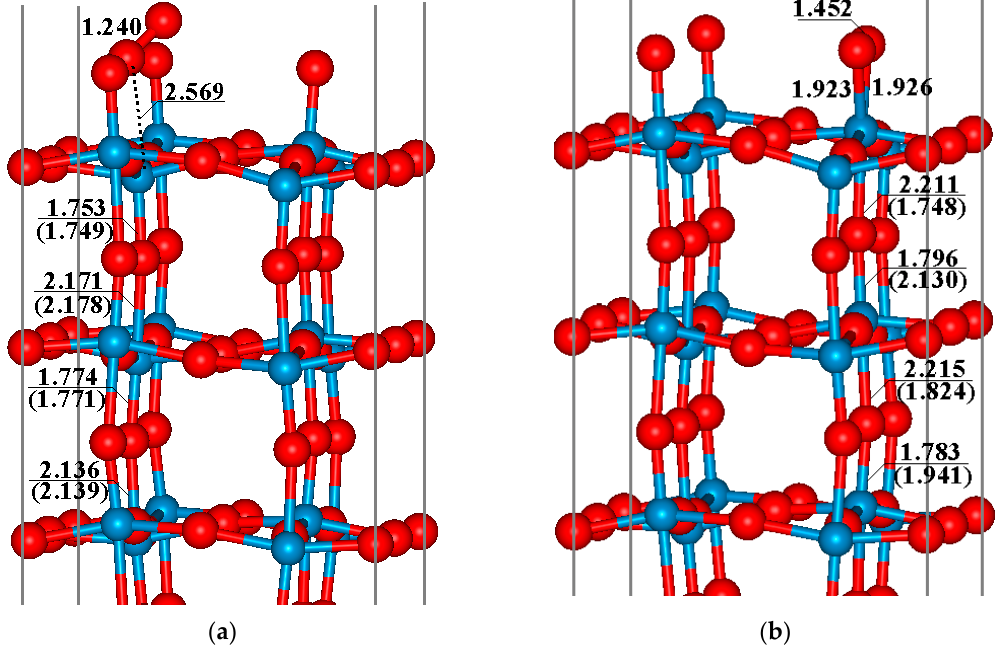
Figure 2. Optimized configurations of O 2 adsorption on ( a ) perfect and ( b ) defective WO 3 (001) surface, respectively. The bond lengths (Å) near the adsorption site are given, and the data in the parenthesis are in relative to the value before O 2 adsorption. Only the top three layers are shown in the figure.